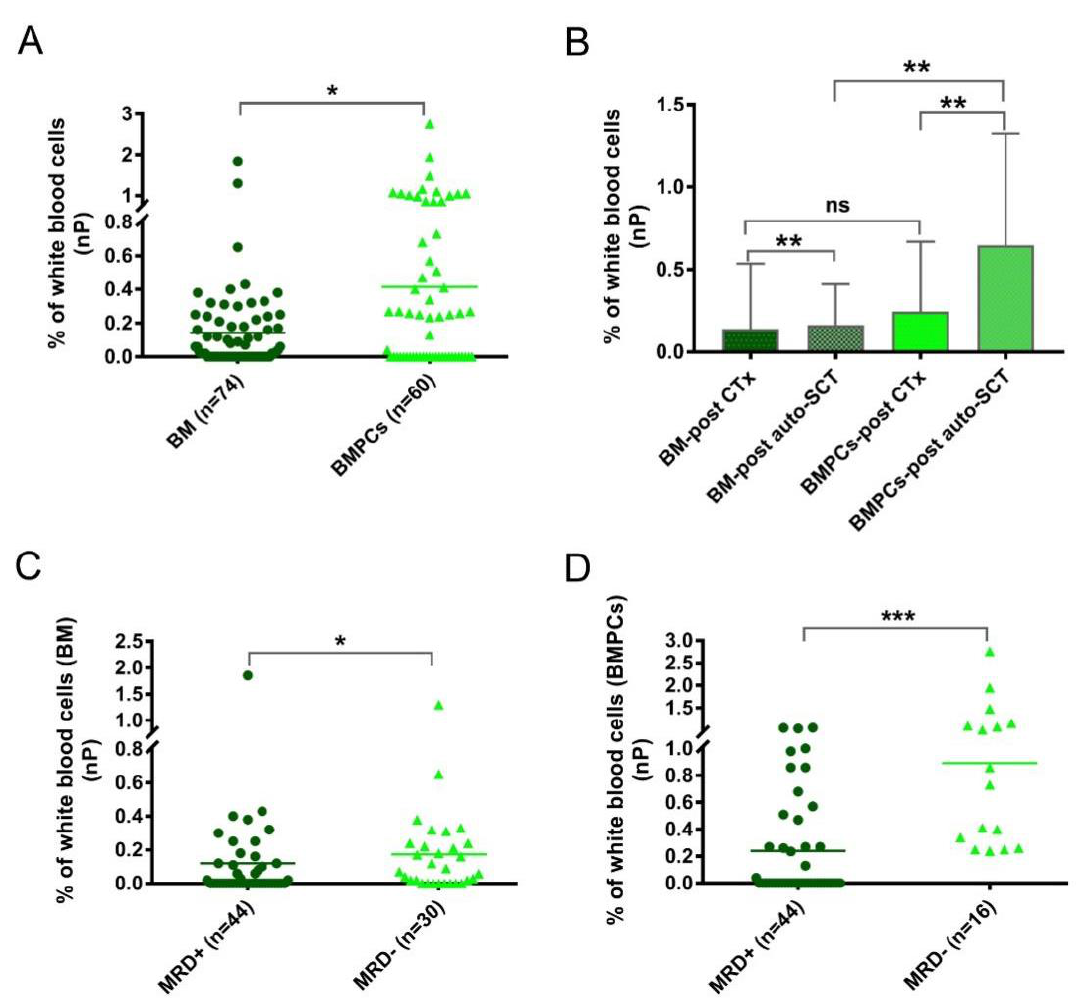
Figure 3. ( A ) The percentages of normal plasma cells (nPC) were determined with conventional bone marrow (BM) or enriched bone marrow particle cell (BMPL) samples from patients after treatment. The percentages of nPCs were higher (* p = 0.023) in the BM samples ( n = 74) than in the BMPL samples ( n = 60). ( B ) Comparison of the nPC numbers in patients with different treatment regimes and different samples (BM and BMPL). The percentages of nPCs were higher (BM: ** p = 0.0067; BMPL: ** p = 0.0025) in patients after autologous stem cell transplantation (auto-SCT) (BM: n = 44; BMPL: n = 34) than in patients after treatment with standard chemotherapy (CTx) (BM: n = 30; BMPL: n = 26). The BMPL samples from patients after auto-SCT had higher (** p = 0.0012) percentages of nPCs compared to the BM samples from patients after auto-SCT. No significant differences were observed between the BM samples and BMPL samples from patients after treatment with CTx. ( C , D ) Patients’ samples after treatment were divided into MRD + ( ≥ 0.001% aPC) and MRD − (<0.001% aPC). The percentages of nPCs were higher (BM: * p = 0.041; BMPL: *** p < 0.0001) in the MRD − samples than in the MRD + samples. The graphs show the mean ( A , C , D ) or mean ± standard deviation ( B ), Mann – Whitney U test ( A – D ).